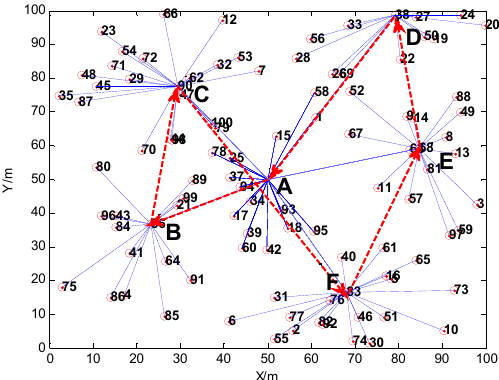
Figure 12. The result of path planning after considering the distance factor and path selection probability.